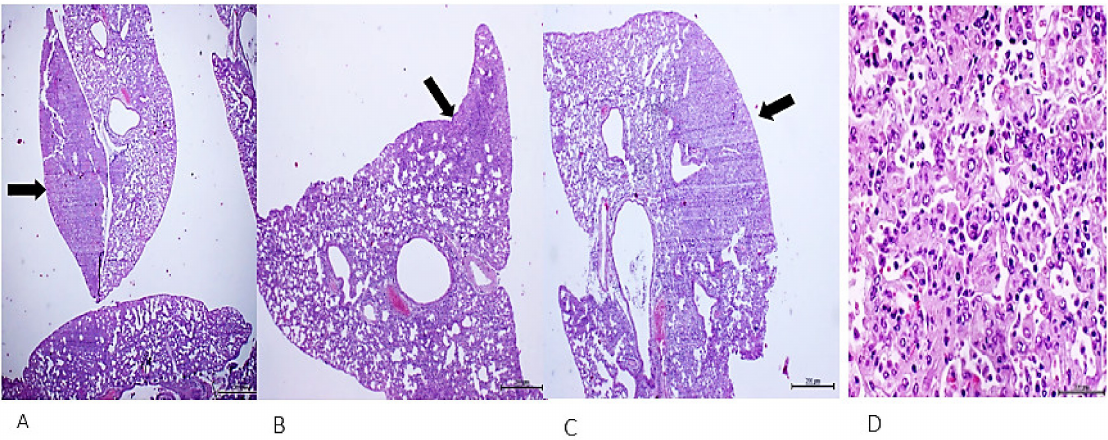
Figure 5. Autonomous growth of lung tumors. Mice treated with the sarcoma homogenate for 32 days and left to evolve free-of-treatment for other 35 days, exhibited lungs parenchymal consolidated areas ( A – C ) that were histologically concluded as poorly-differentiated adenocarcinomas. H/E. Magnification: × 4 from ( A – C ) and × 40 for ( D ). Scale bar: 200 µ